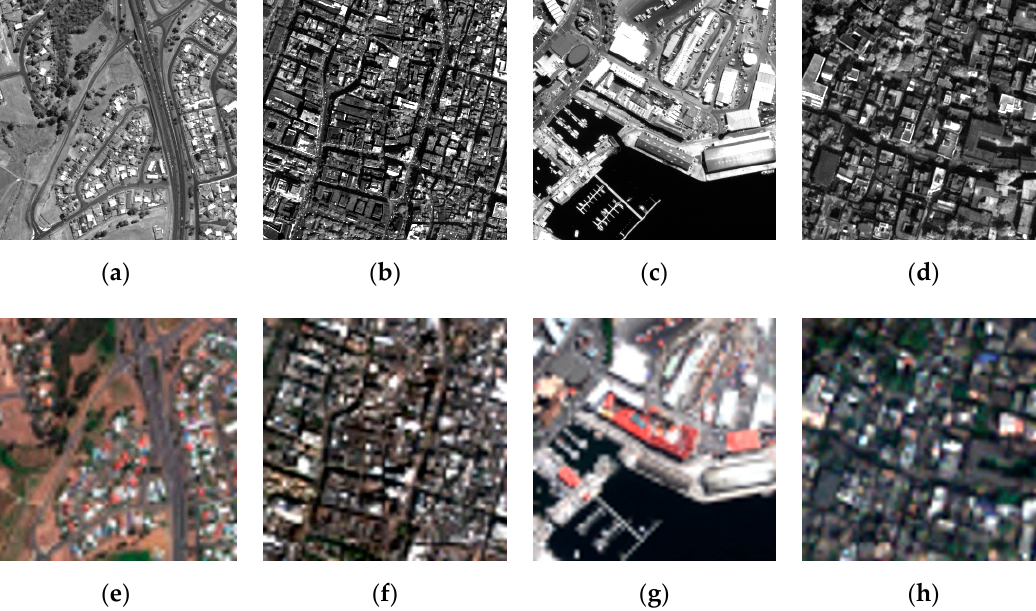
Figure 6. Experimental data sets used for assessment (images in a,e and c,g came from the GeoEye-1 satellite, and images in b,f and d,h were collected from the QuickBird satellite): ( a ) degraded PAN image 1; ( b ) degraded PAN image 2; ( c ) real PAN image 1; ( d ) real PAN image 2; ( e ) degraded MS image 1; ( f ) degraded MS image 2; ( g ) real MS image 1; and ( h ) real MS image 2.